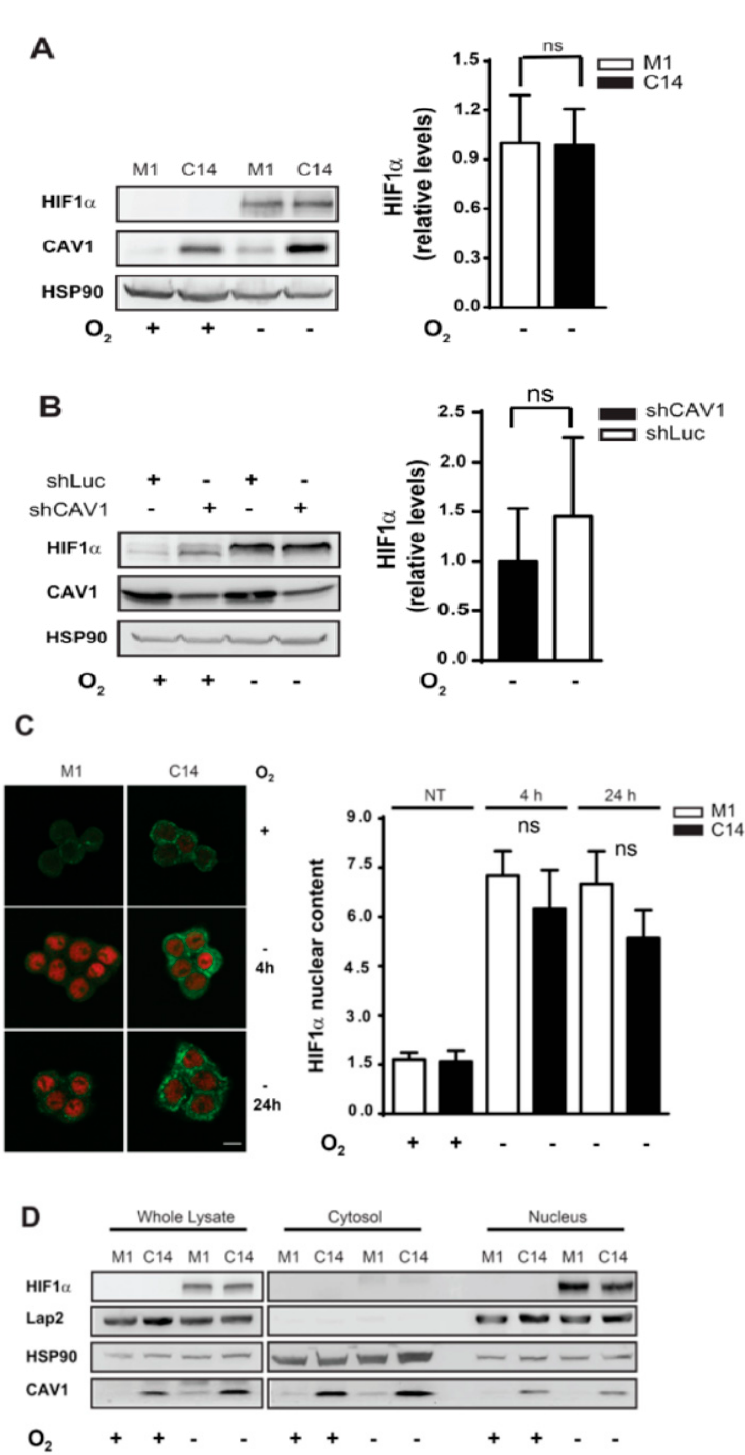
Figure 3. Suppression of HIF1 α activity by CAV1 in cells exposed to hypoxia is independent of HIF1 α degradation or sequestration. Cell extracts (50 µg total protein) were separated by sodium dodecyl sulfate polyacrylamide gel electrophoresis (SDS-PAGE) and then analyzed by Western blotting. HIF1 α protein levels in A) HT29(US) (M1) (white bars) and (C14) (black bars) and B) MDA-MB-231